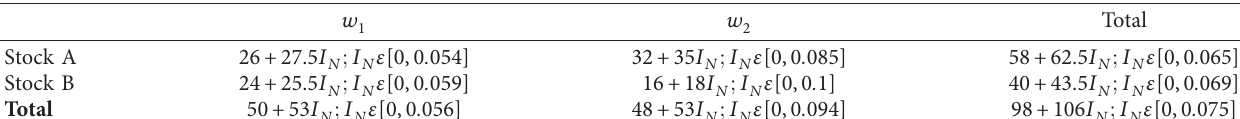
Table 4: Neutrosophic form of payoff for two stocks.